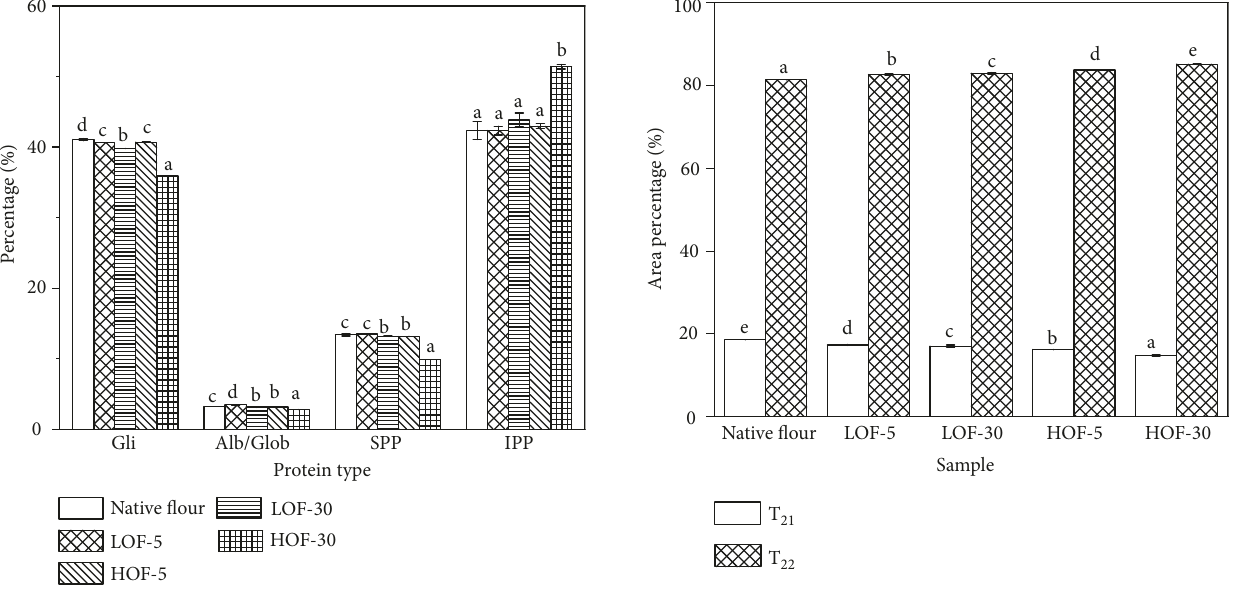
Figure 3: Percentages of protein fractions of native and ozone- treated wheat flours. For a specific protein fraction, means with the same letter were not significantly different ( α � 0.05). LOF-5: wheat flour treated at low-intensity condition for 5 min; LOF-30: wheat flour treated at low-intensity condition for 30min; HOF-5: wheat flour treated at high-intensity condition for 5 min; HOF-30: wheat flour treated at high-intensity condition for 30min.